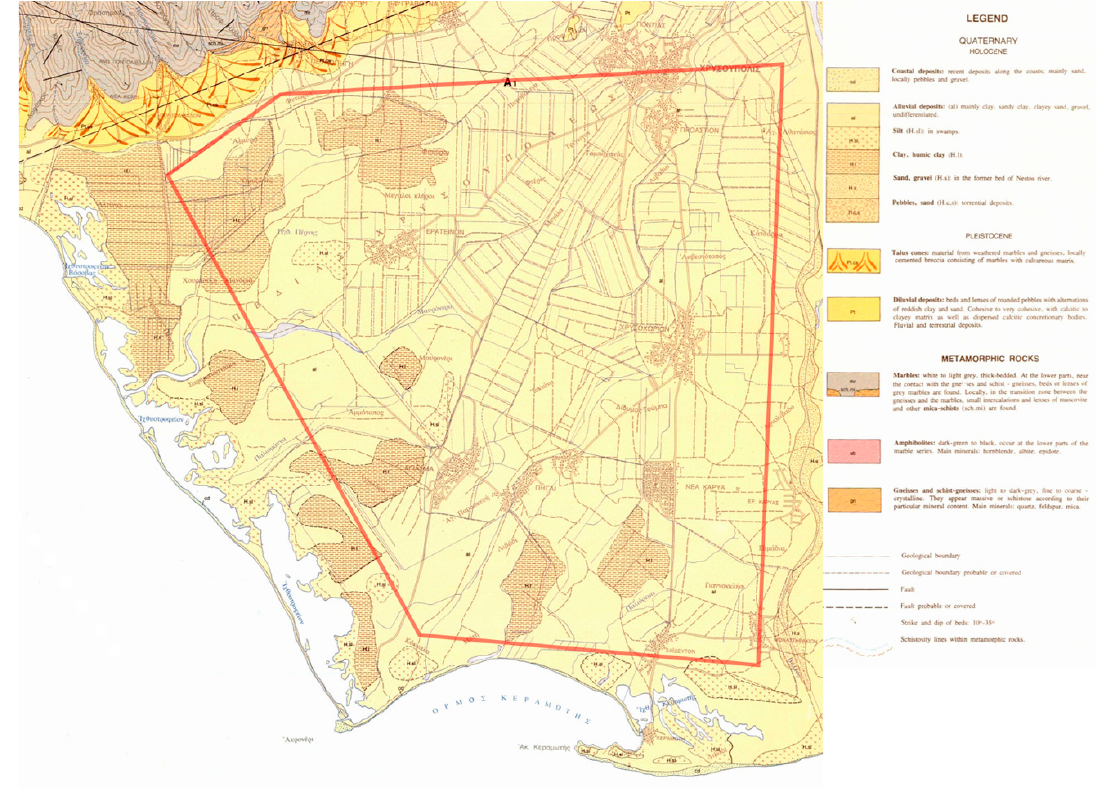
Figure 2. Geological map of the study area (outlined) [33].